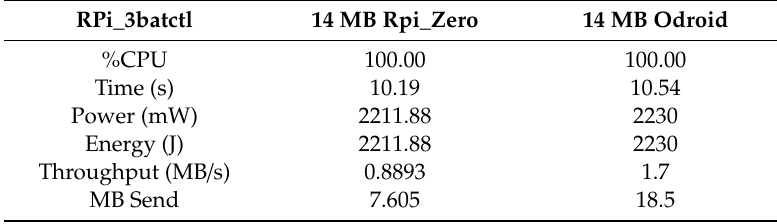
Table 4. Test Ad hoc-batctl / batman-adv RPi